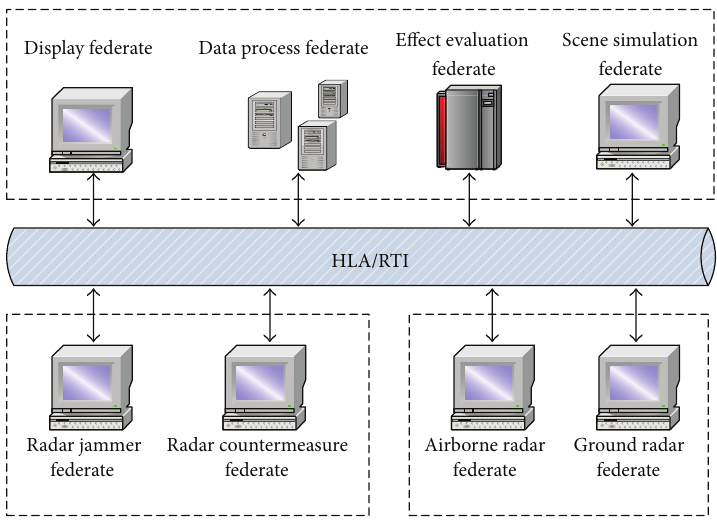
Figure 11: The architecture of a radar training simulation